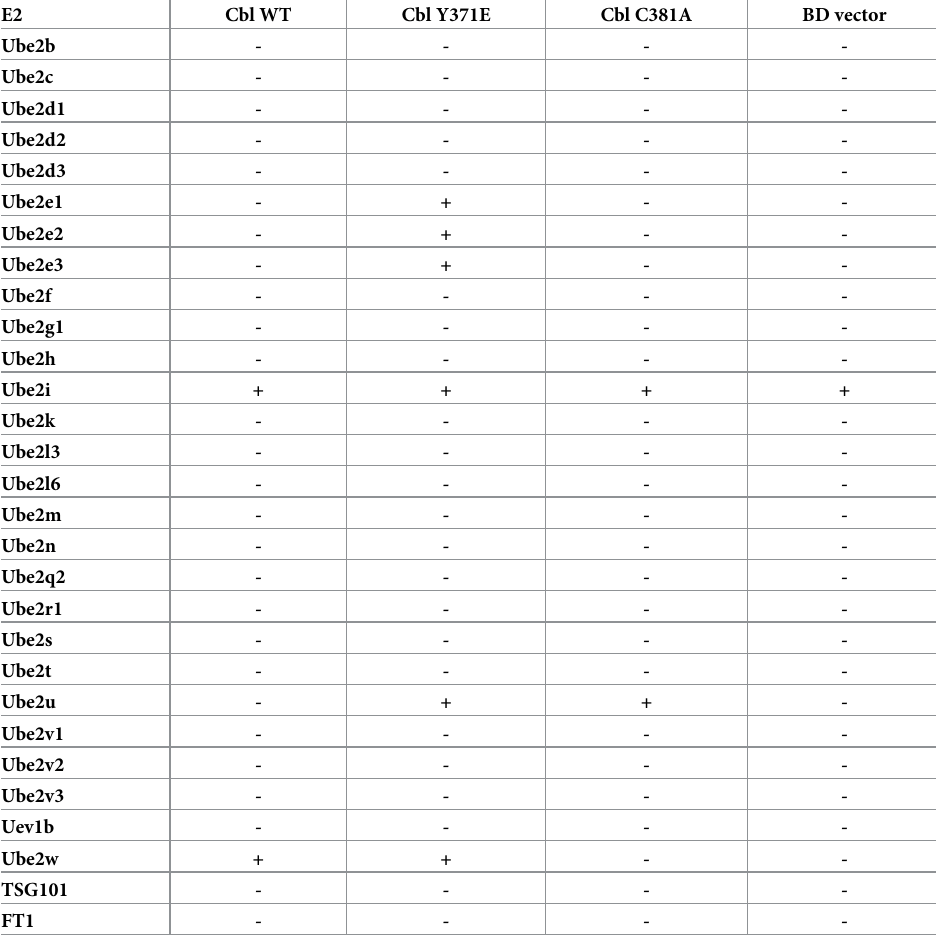
Table 2. E2s tested for interaction with Cbl in yeast two-hybrid screen.